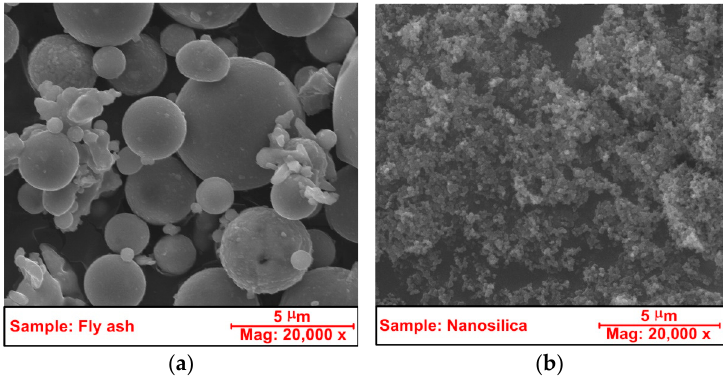
Figure 1. SEM micrographs of SCMs used: ( a ) coal fly ash, ( b ) nanosilica. The specific density of the fine aggregate, i.e., pit sand (FA), used with a maximum diameter of 2 mm is 2.60 g/cm 3 , and the compressive strength is 33 MPa. Natural gravel is used as the coarse aggregate (CA), with a maximum particle size of 8 mm. The specific density is 2.65 g/cm 3 , and the compressive strength is 34 MPa. Water (W) represents laboratory pipeline water free from